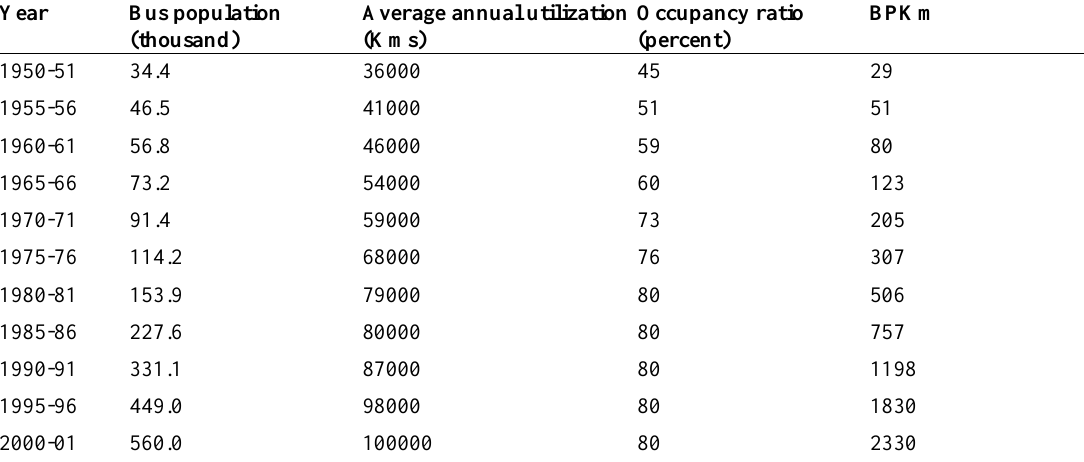
Table A2. Growth of Indian bus industry; 1950-51 to